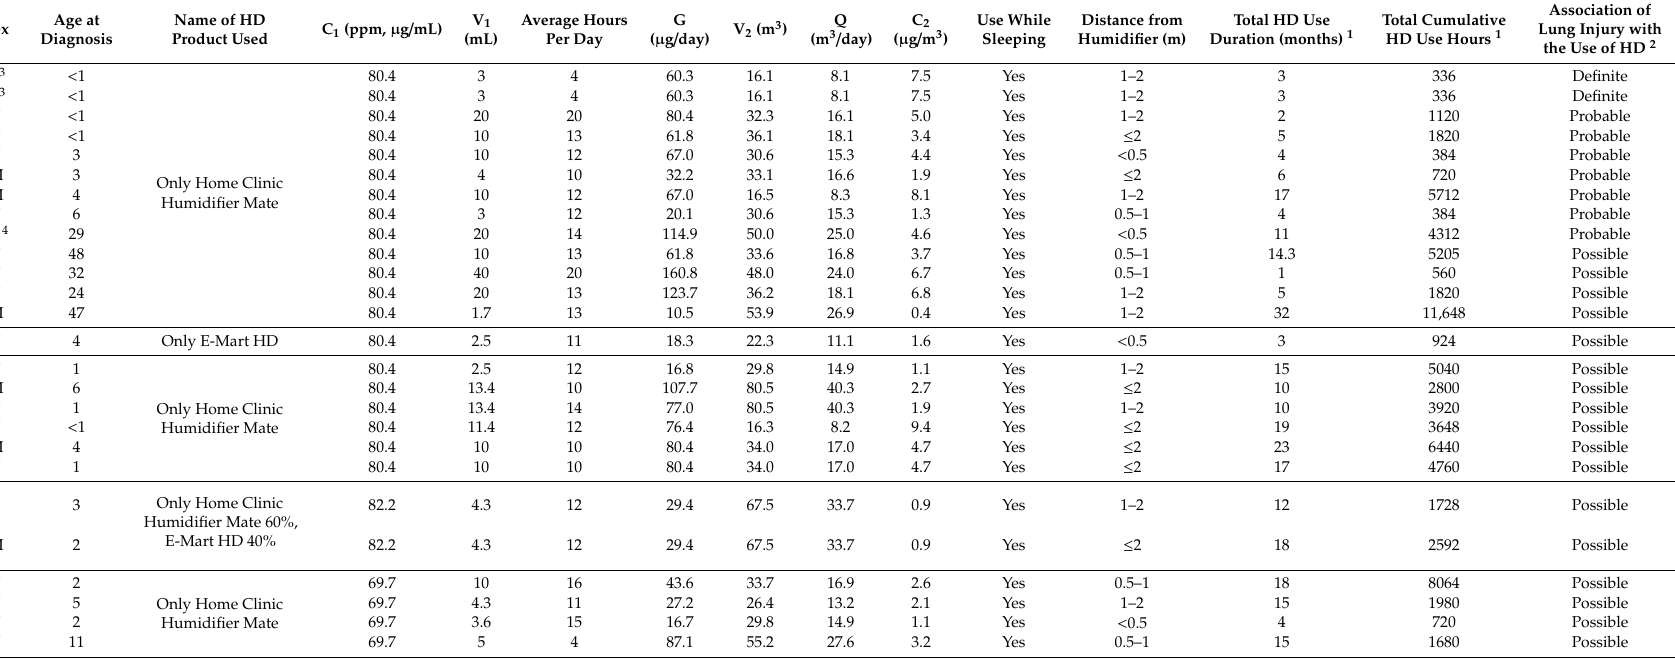
Table 4. Estimated airborne CMIT and MIT levels based on HD use characteristics of humidifier disinfectant-associated lung injury (HDLI) patients with clinically definite, probable, and possible association with use of HD ( n =